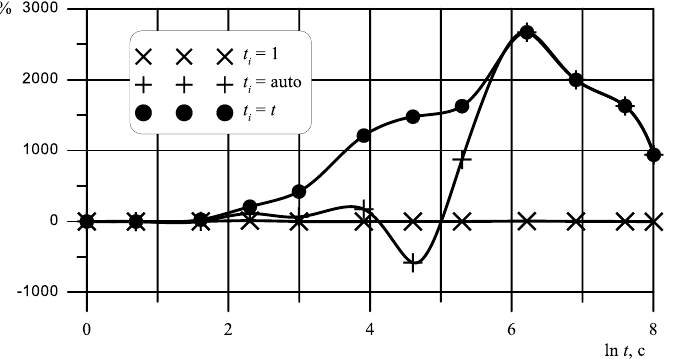
Fig. 8. The errors of solutions of the problem of stretching, obtained by different methods, relative to the analytical method at different step of integration